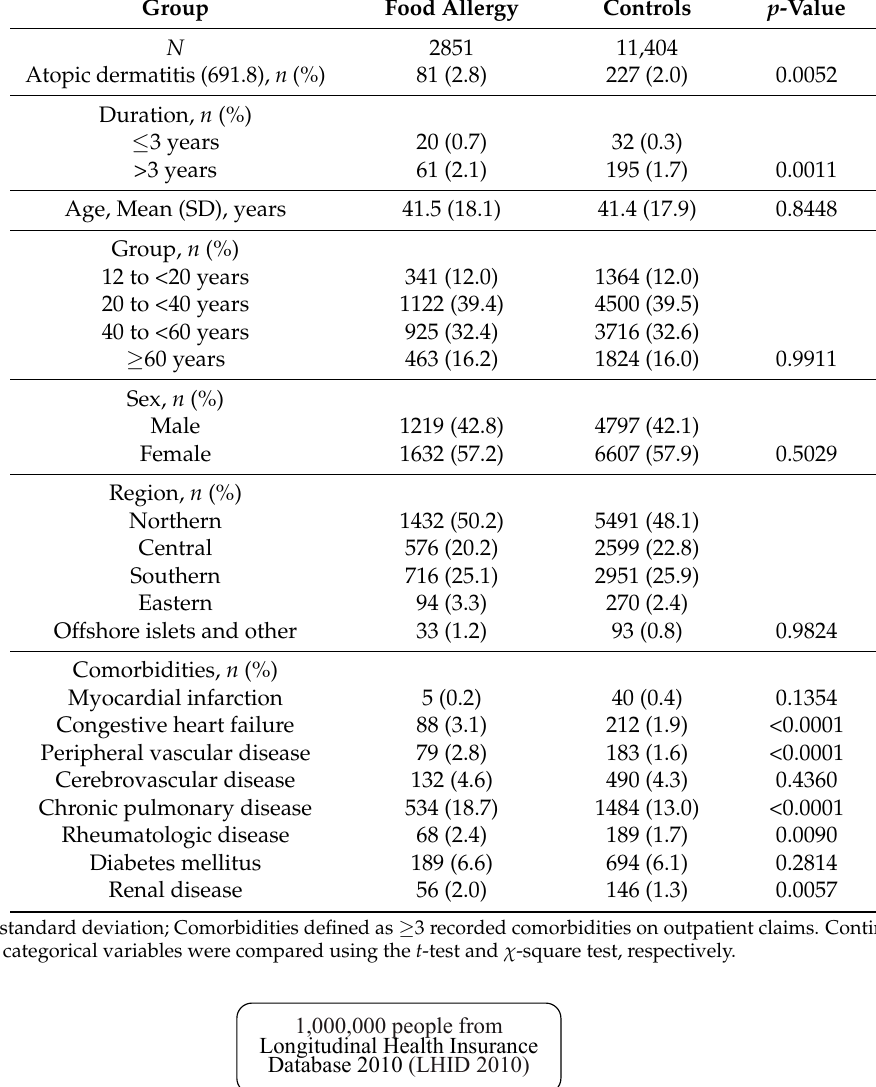
Table 1. Characteristics of subjects with food allergy and matched controls (1:4). Group Food Allergy Controls p -Value 2851 11,404 Atopic dermatitis (691.8), n (%)